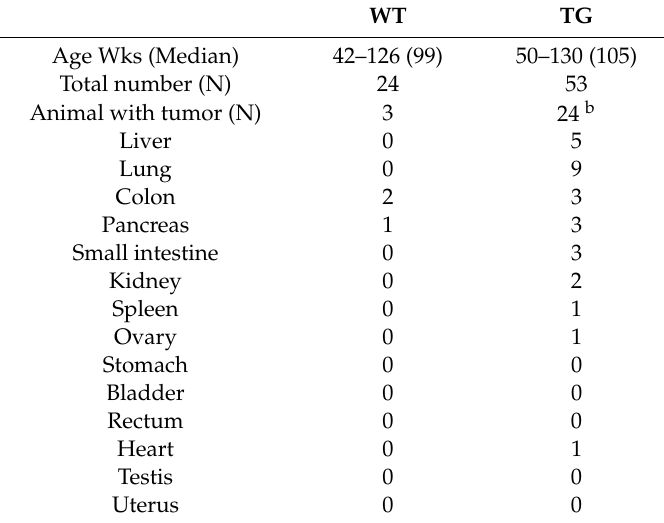
Table 1. Spontaneous tumor incidence in WT and TG mice